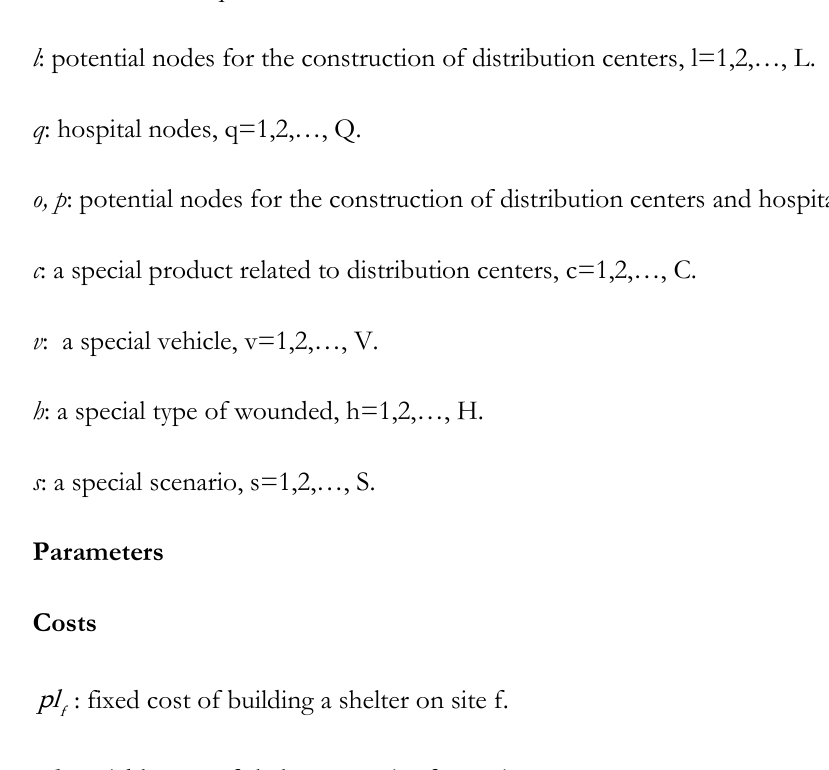
pl : fixed cost of building a shelter on site f